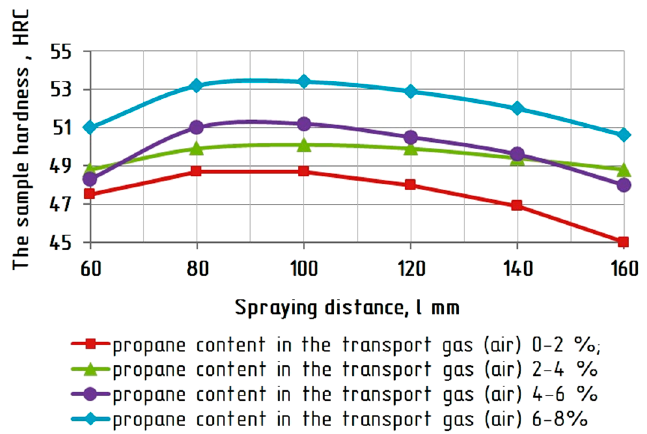
Figure 7. The dependence between the coating hardness of PN55T45 powder and the spraying distance with the content of propane in a plasma-forming gas (air): (red) 0–2%; (green) 2–4%; (purple) 4–6%; (blue) 6–8%.